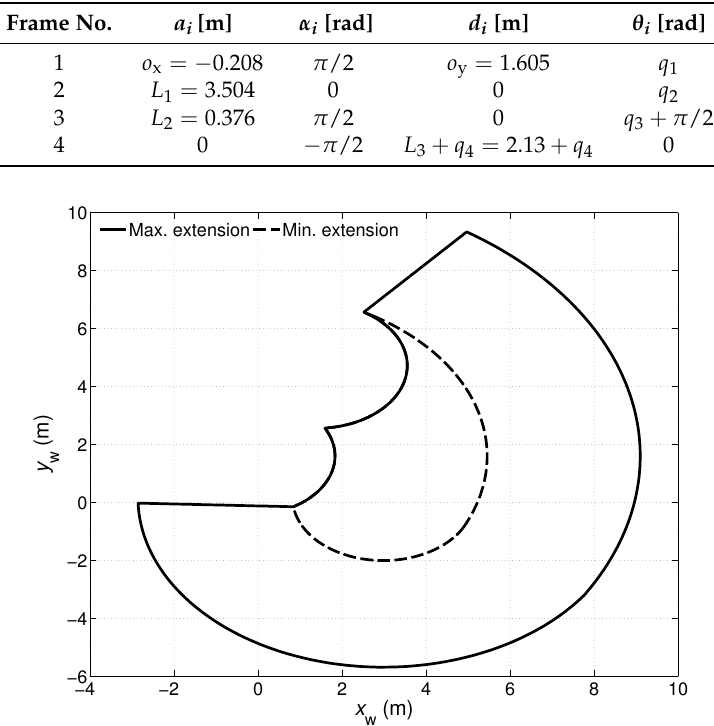
Figure 6. Theoretical reachable workspaces of the K70M hydraulic manipulator in this vertical plane. Reachable workspaces with maximum ( q 4 = 3.7 m) and minimum extension ( q 4 = 0 m) have been